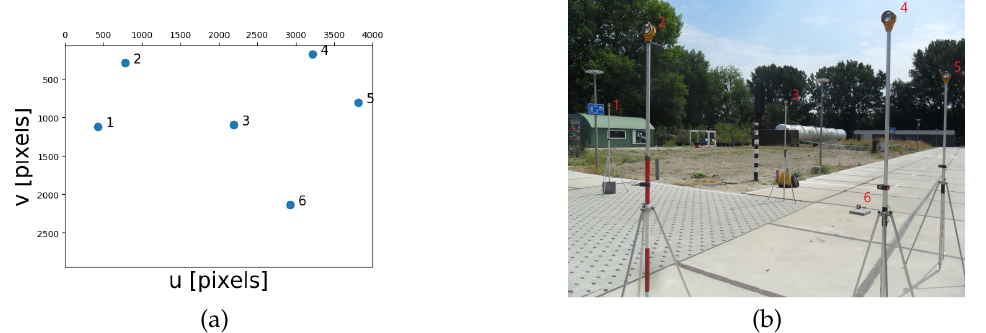
Figure 16. ( a ) Visualization of experiment setup, photograph of the reflectors (landmarks) from the camera perspective ( b ) Image taken by the camera. The image measurements are obtained by manually selecting the geometric centre of the reflectors in the image. The experiment was carried out at the Green Village on the TU Delft